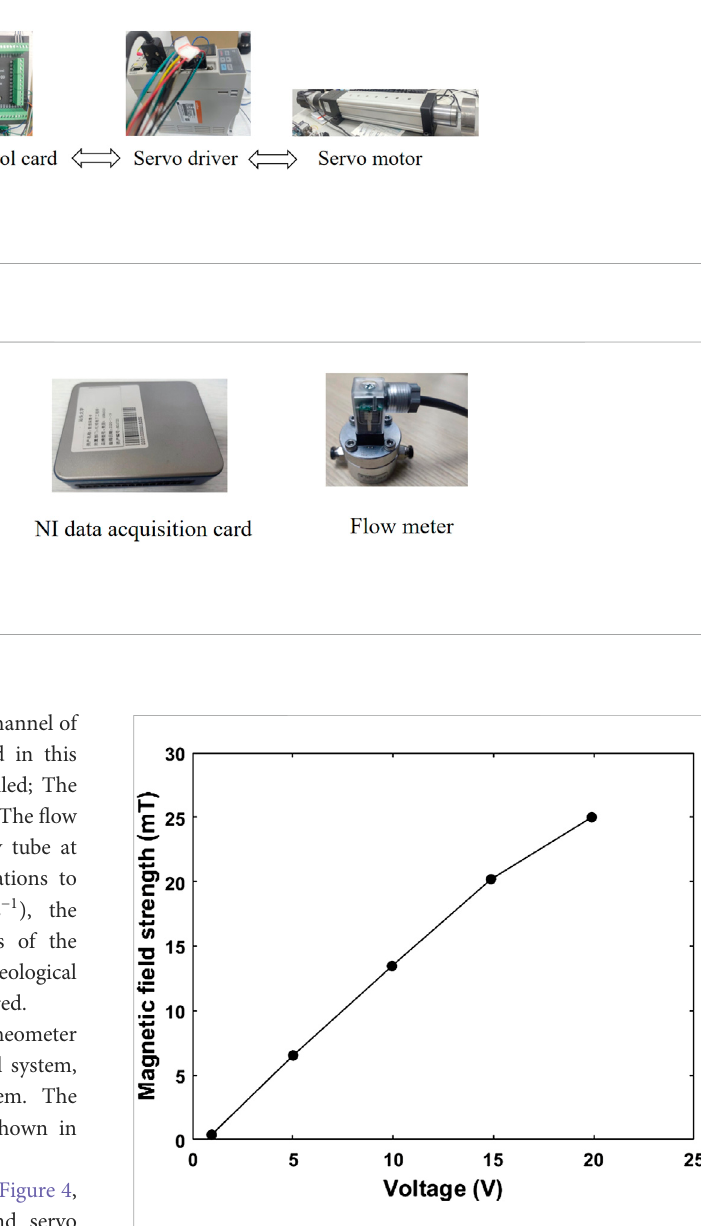
FIGURE 6 The magnetic fi eld strength of Helmholtz coil varies with the output voltage of power